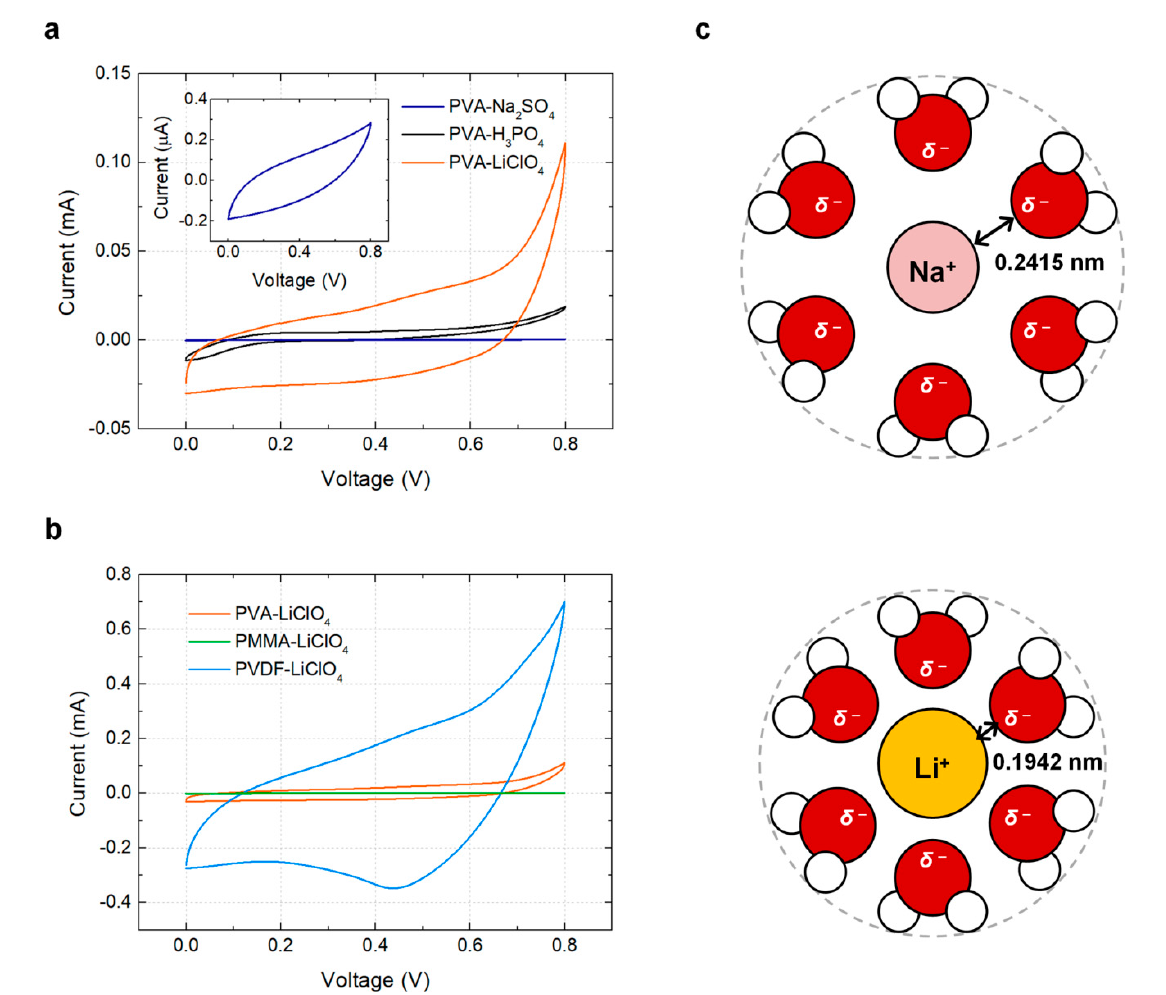
Figure 2. Performance comparison between GPEs. ( a ) Cyclic voltammetry results of the printed supercapacitors using aqueous GPEs with various supporting salts (Formulations 1, 2 and 3). The inset shows a magnified view of the PVA–Na 2 SO 4 curve. ( b ) Cyclic voltammetry results for GPEs with various polymer matrices (Formulations 3, 4 and 5). ( c ) Schematic images of the hydrate forms of Na + and Li + .